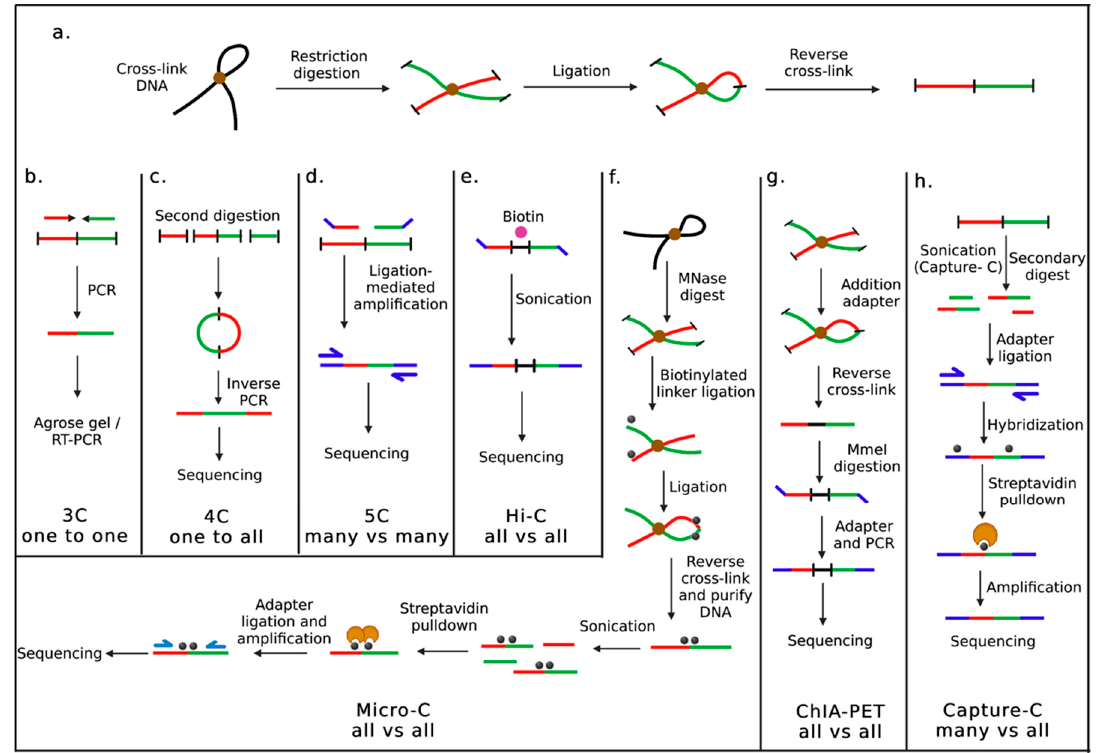
Figure 1. Techniques for studying chromatin organization in three-dimensional (3D) space. Steps involved in studying the 3D organization of genomes, ( a ) A common step in 3C-related techniques is crosslinking chromosomes with formaldehyde and their fragmentation by restriction digestion. The organization of chromatin can be visualized in 3D space using several different detection approaches such as ( b ) 3C (chromosome conformation capture), ( c ) 4C (chromosome conformation capture-on-Chip), ( d ) 5C (chromosome conformation capture carbon copy), ( e ) Hi-C, ( f ) Micro-C, ( g ) ChIA-PET (chromatin interaction analysis paired-end tag sequencing) and ( h ) Capture-C. This figure was created using BioRender.com access on 14 December 2022.